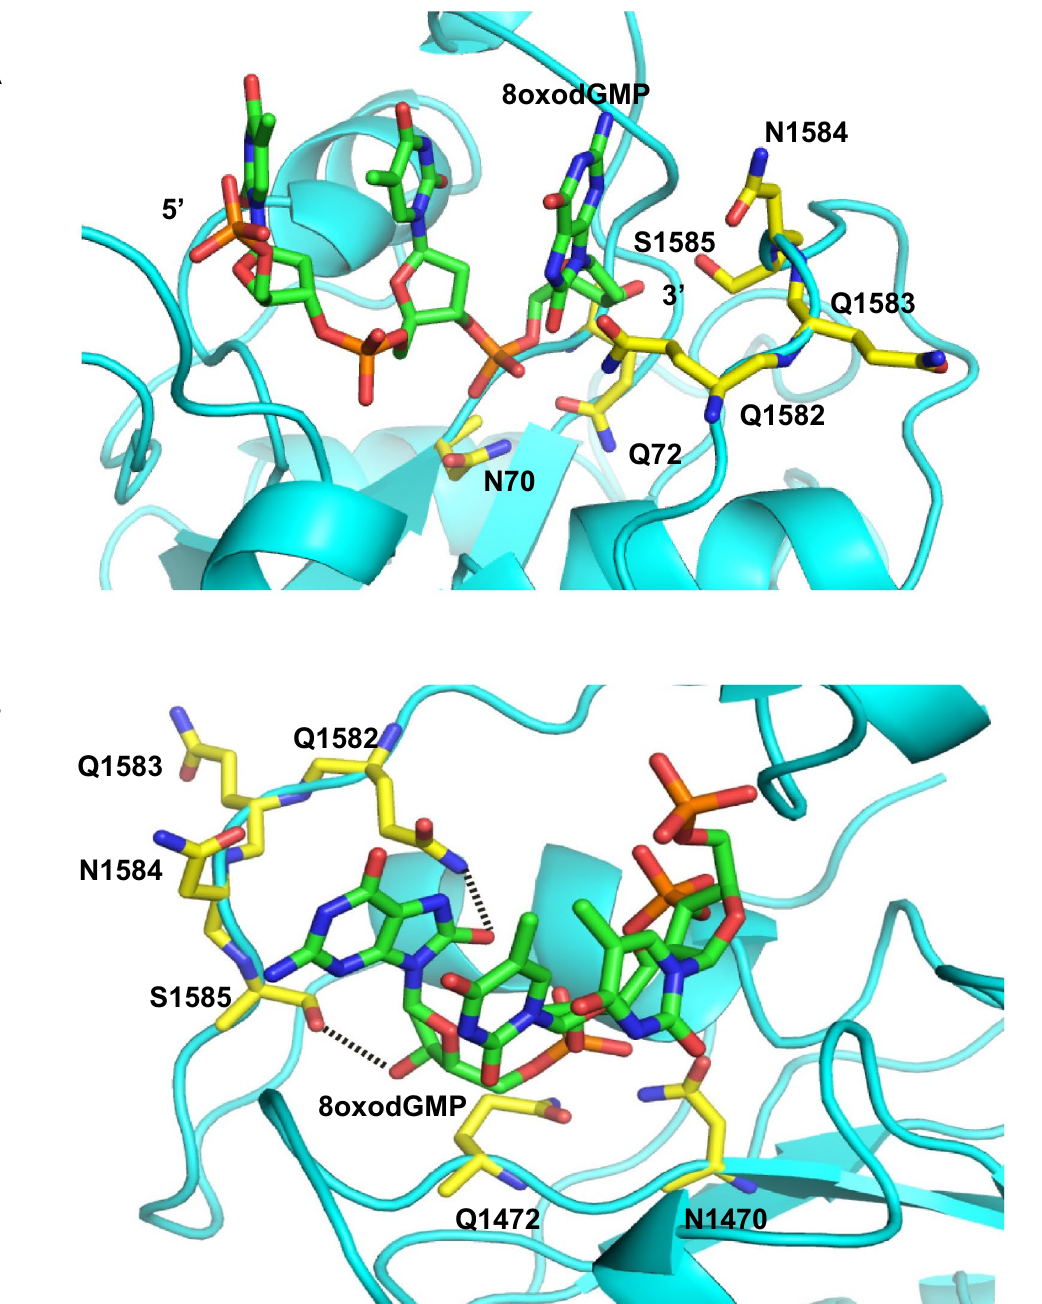
Figure 3. Model of the PfpPol exonuclease domain in complex with 8oxodGMP terminated single stranded DNA. ( A ) A computational model of PfpPol exonuclease domain in complex with DNA is displayed. The secondary structure elements and the residues are shown in cartoon and stick representation, respectively. The residues of the stretch 1582 QQNS 1585 were found close to 8oxodGMP. N1470 and Q1472 represent mutant versions of the catalytic residues, which are present close to the target phosphodiester bond. ( B ) The possible hydrogen bonds formed between S1585 and Q1582 with the 3 ′ end of the primer and the oxidized base, respectively, are displayed as dotted